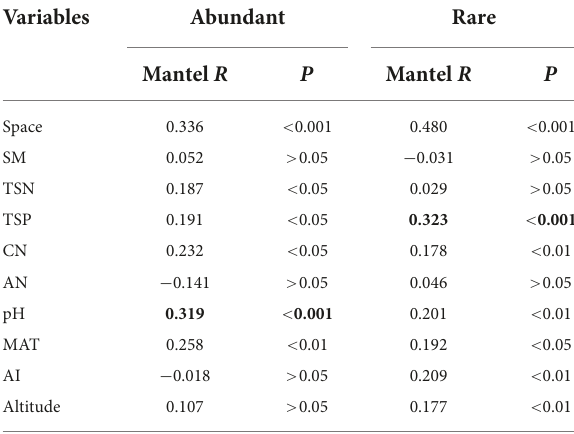
TABLE 2 Mantel test results showing internal links of β -deviation and environmental and spatial